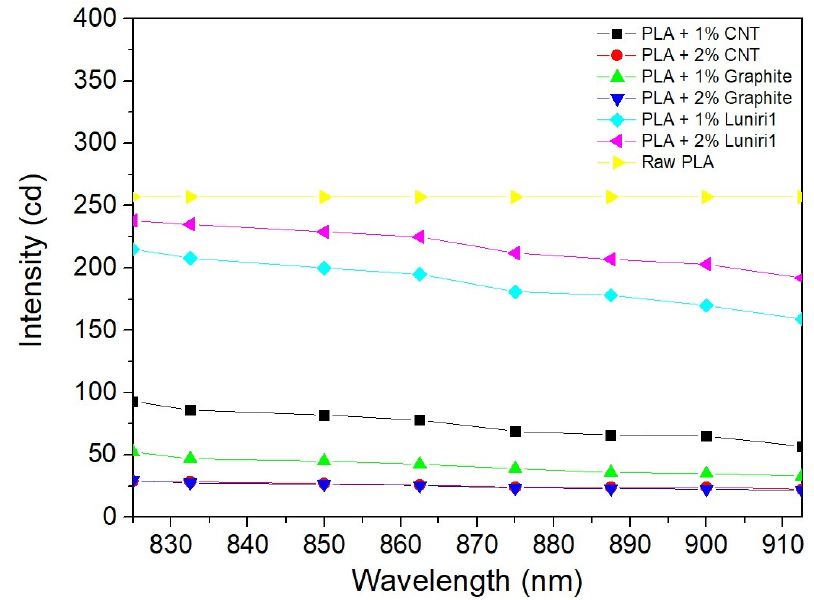
Figure 9. Light transmission of PLA filaments with different additives.